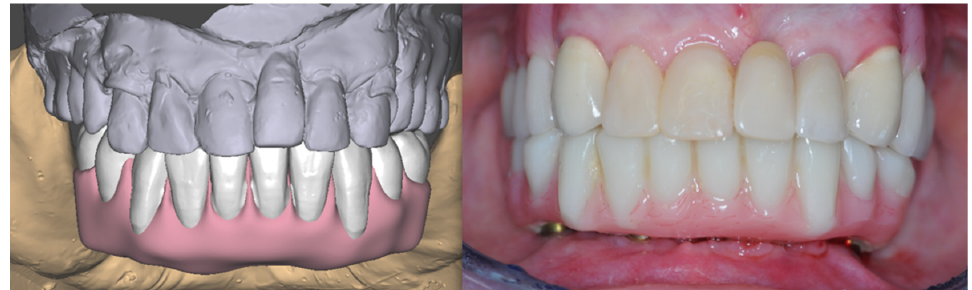
Figure 19. Comparison between digital plan and post-op results.